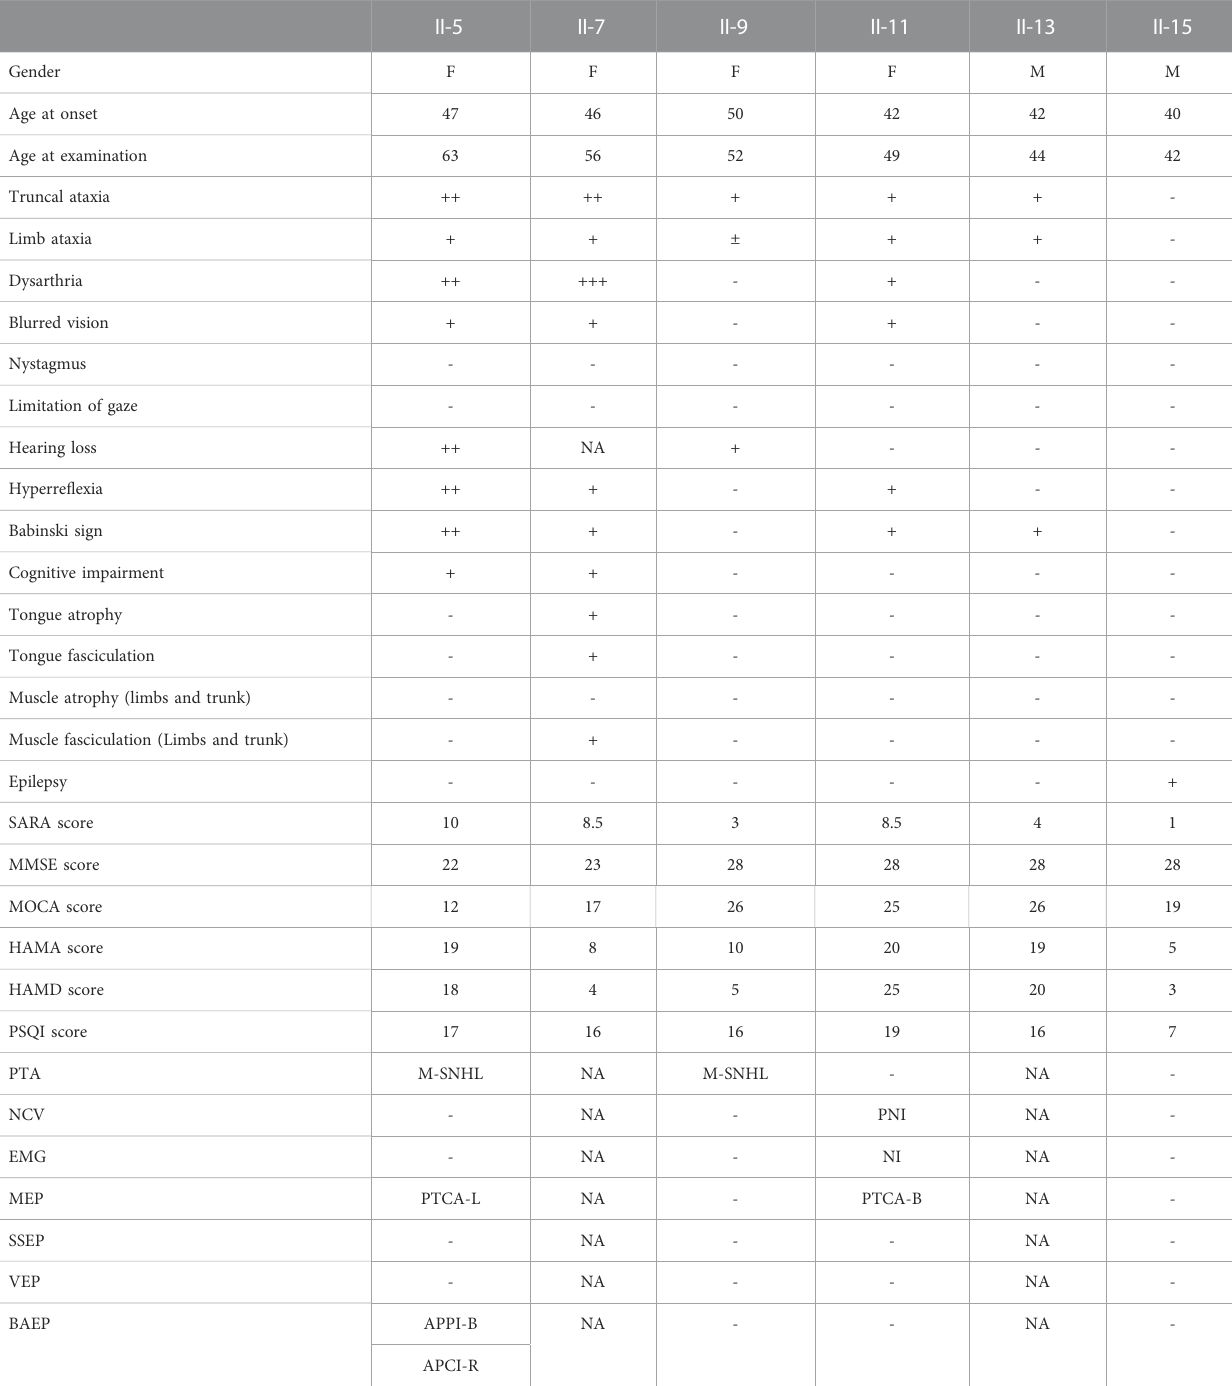
TABLE 1 The Clinical features of